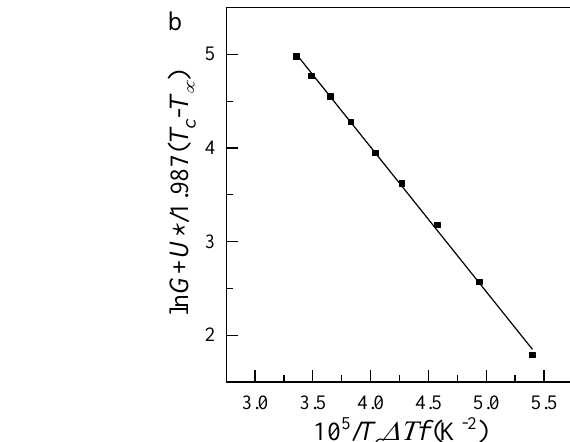
Figure 8. ( a ) Growth rate G ( µ m · s − 1 ) as a function of T c for PLLA films; ( b ) Changes in lnG + U* / R ( T c − T ∞ ) as a function of 1/ T c ∆ Tf.